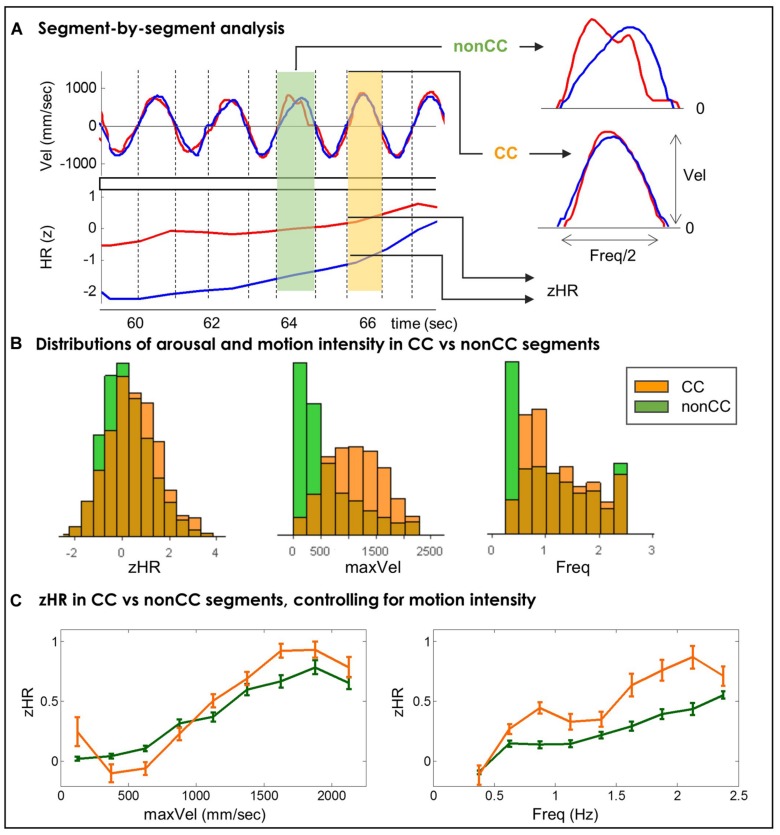
(A) A Segment-by-segment analysis. Motion segments are defined as periods between zero velocity events. For each segment we computed its motion intensity (Freq and MaxVel), its physiological arousal (zHR) and a binary marker of kinematic togetherness (CC or non-CC). (B) Distributions of players’ HRs and motion intensity in CC and non-CC segments. In CC segments compared to non-CC segments, players demonstrate higher z-normalized heart-rates, and move at higher velocities and higher frequencies. (C) zHR in CC vs. non-CC segments, controlling for motion intensity. Average zHR is compared for CC and non-CC segments in same bins of maxVel (left) and Freq (right). In eight out of nine bins of frequency (Table 3) and in one out of nine bins of velocity (Table 4), zHR in CC segments was significantly larger than zHR in non-CC segments.